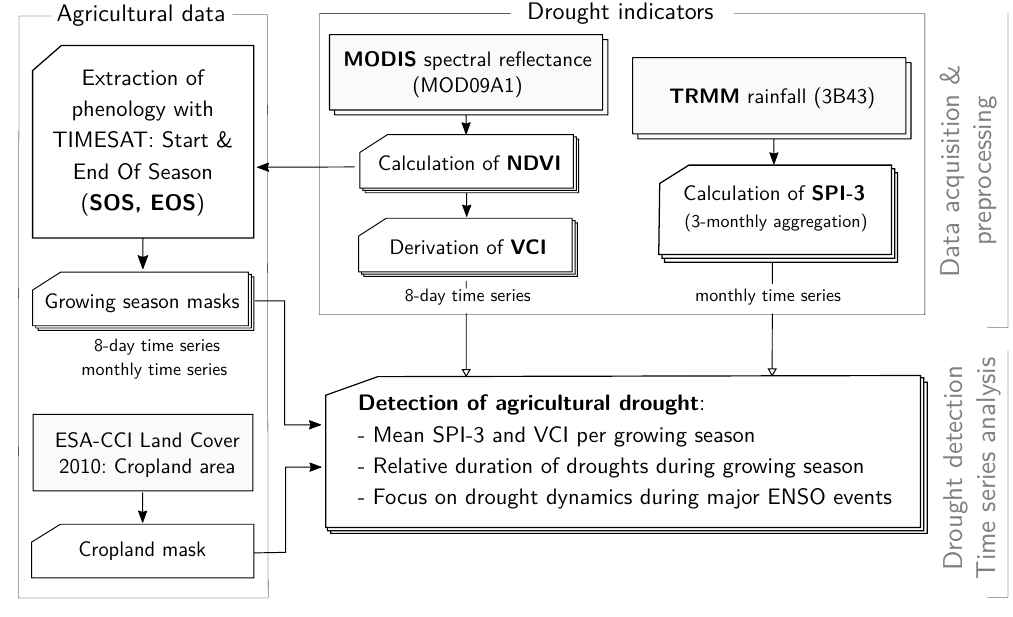
Figure 2. Schematic overview of the methodological approach. Table 1. Remote sensing-based data sets and their specifications utilized in this